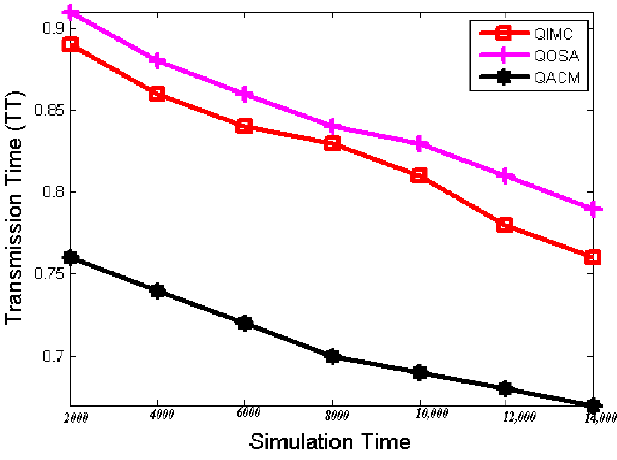
Figure 3. Transmission time.